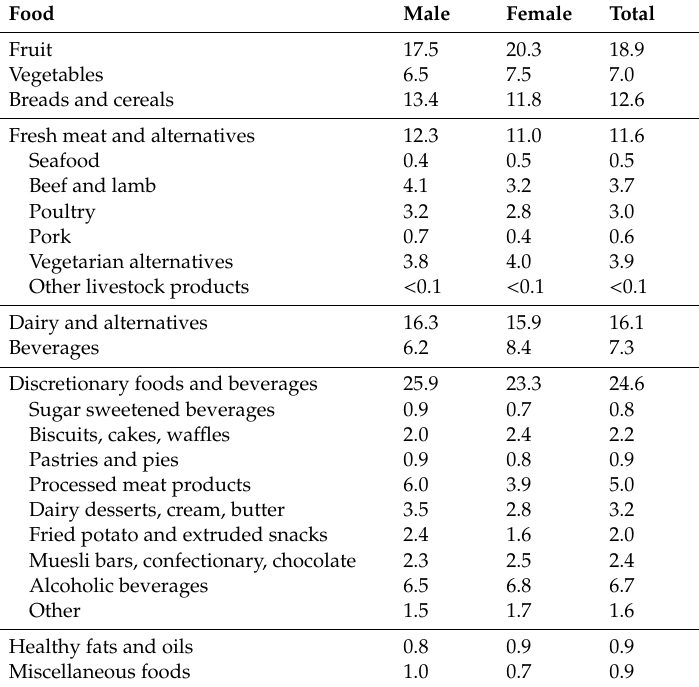
Table 1. Contribution of di ff erent foods (%) to the water scarcity footprint of Australian adult daily diets ( N = 9341). Food groups are as defined by the Australian Dietary